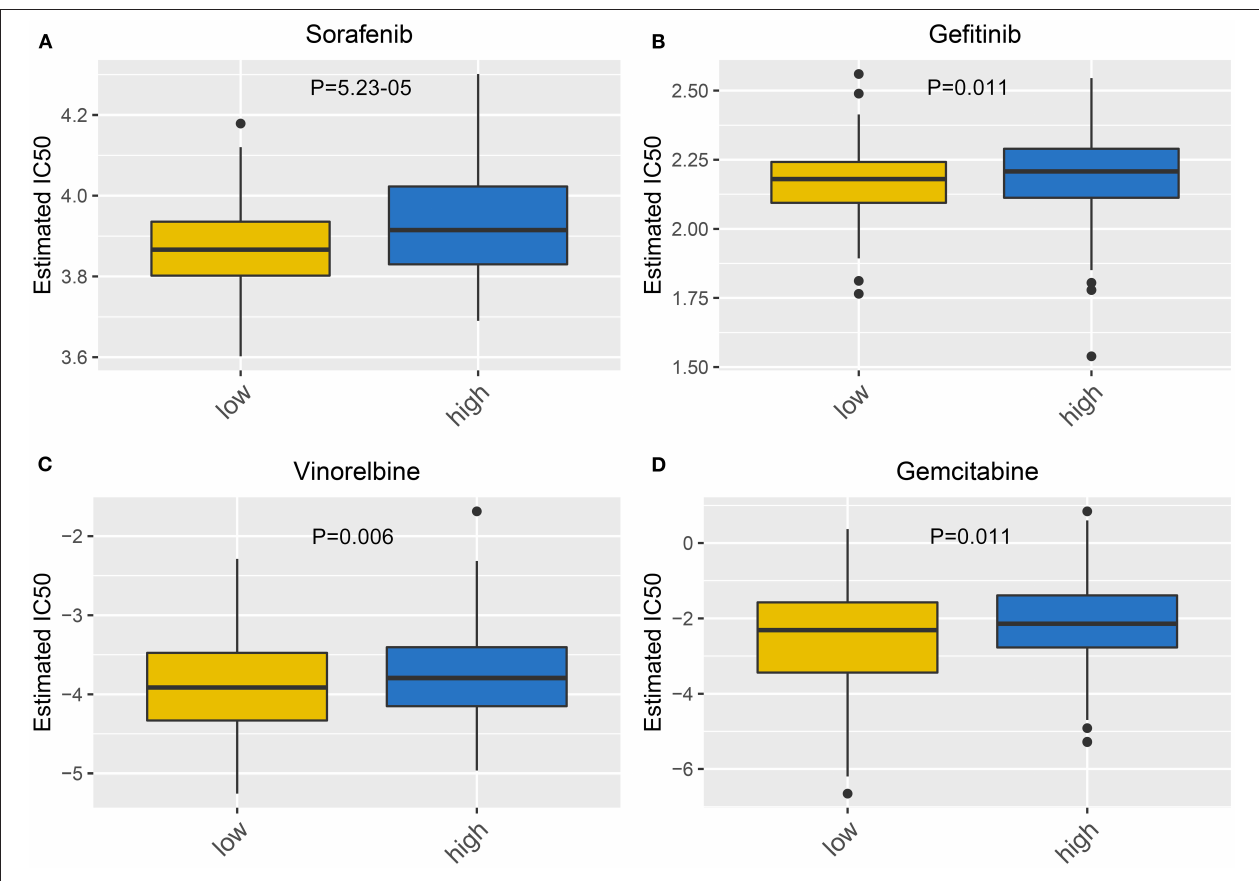
FIGURE 7 | Correlation between this signature and drug sensitivity. Box plots for estimated IC 50 of (A) sorafenib, (B) gefitinib, (C) vinorelbine, and (D) gemcitabine between high- and low-risk gastric cancer specimens.